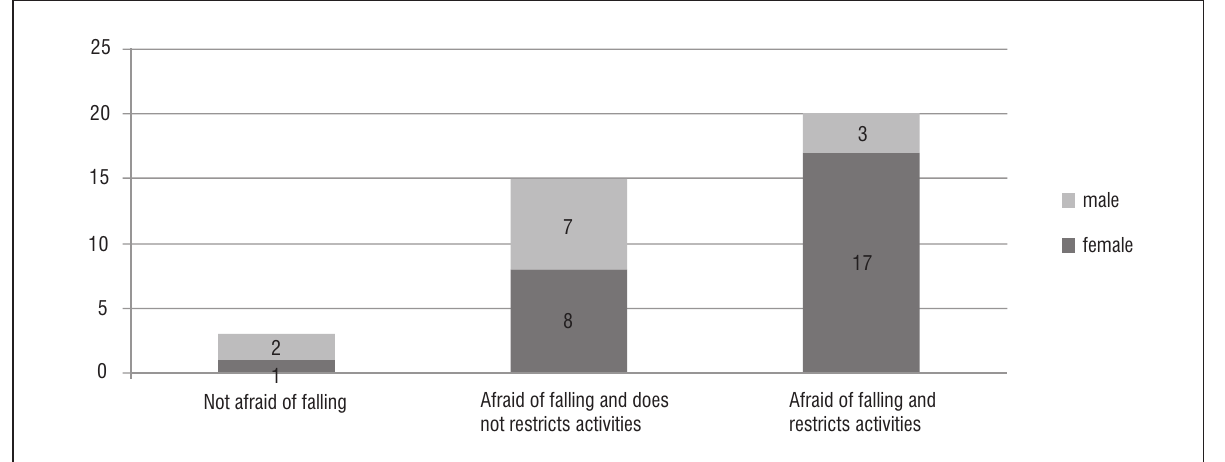
Figure 1 - SAFFE results: classification according to